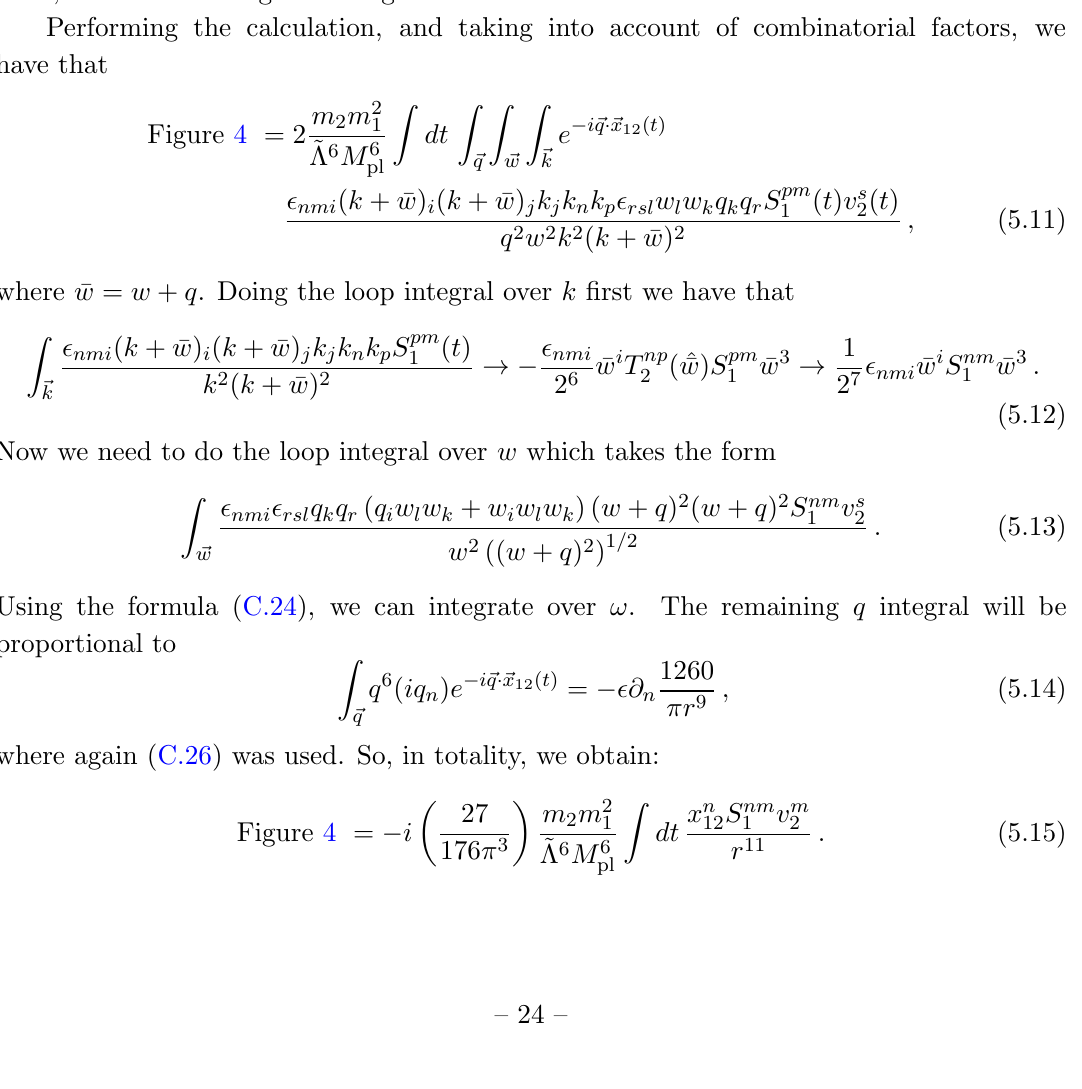
Figure 4 . One of the leading contributions to the e(cid:11)ective potential from ~ topology. The dashed arrow indicates the contraction of tensor indices within one of the two ~ other becoming at this point